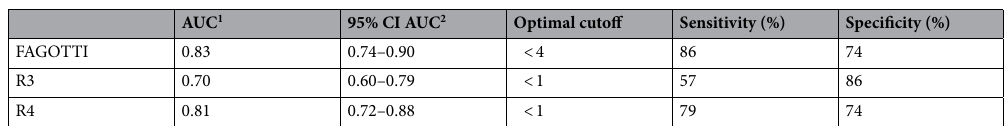
Table 5. Discrimination analysis. Areas Under the ROC Curves. 1 Hanley-McNeil. 2 Exact binomial. Prevalence suboptimal cytoreduction: 15%. Fagotti: SCS Positive predictive value: 37%; SCS Negative predictive value: 97%. R3: SCS Positive predictive value: 42%; SCS Negative predictive value: 92%. R4: SCS Positive predictive value: 35%; SCS Negative predictive value: